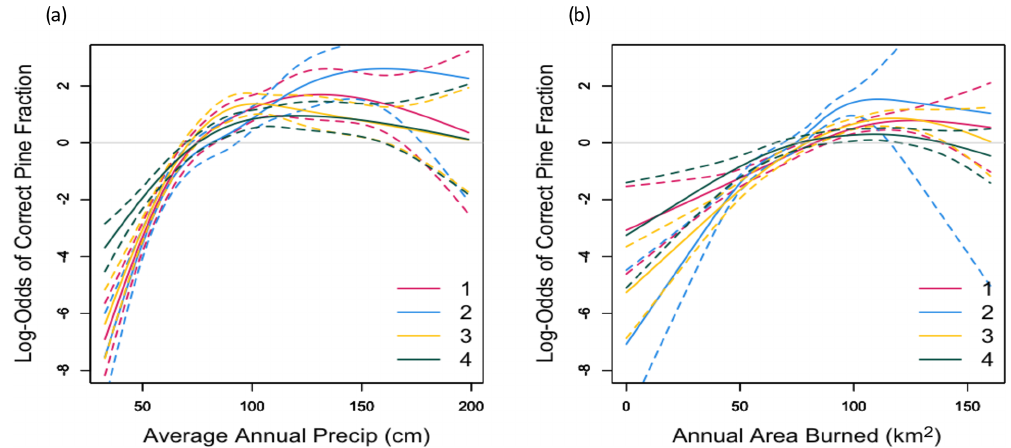
Figure 6. Effects of average annual precipitation (a) and simulated average annual area burned (b) on the log-odds of the correct simulated pine fraction simulated by FATES.